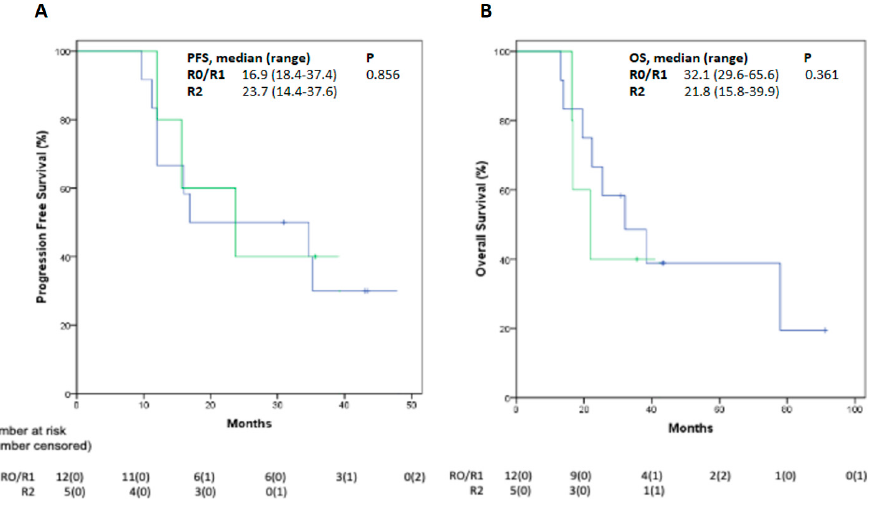
Figure 3. PFS ( A ) and OS ( B ) Kaplan–Meier curves by residual disease (R0 vs. R1/R2). PFS: progression-free survival; OS: overall survival.